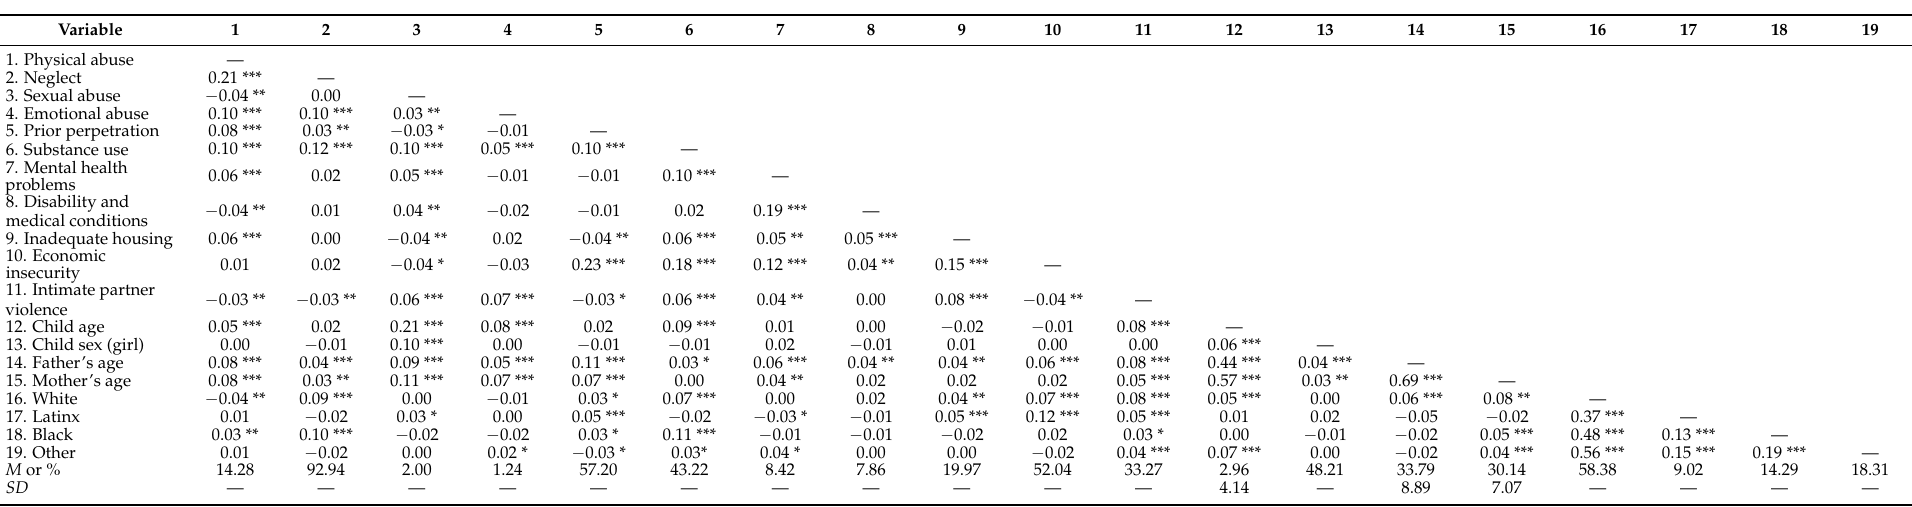
Table 1. Descriptive Statistics and Correlations Between Study Variables ( N =